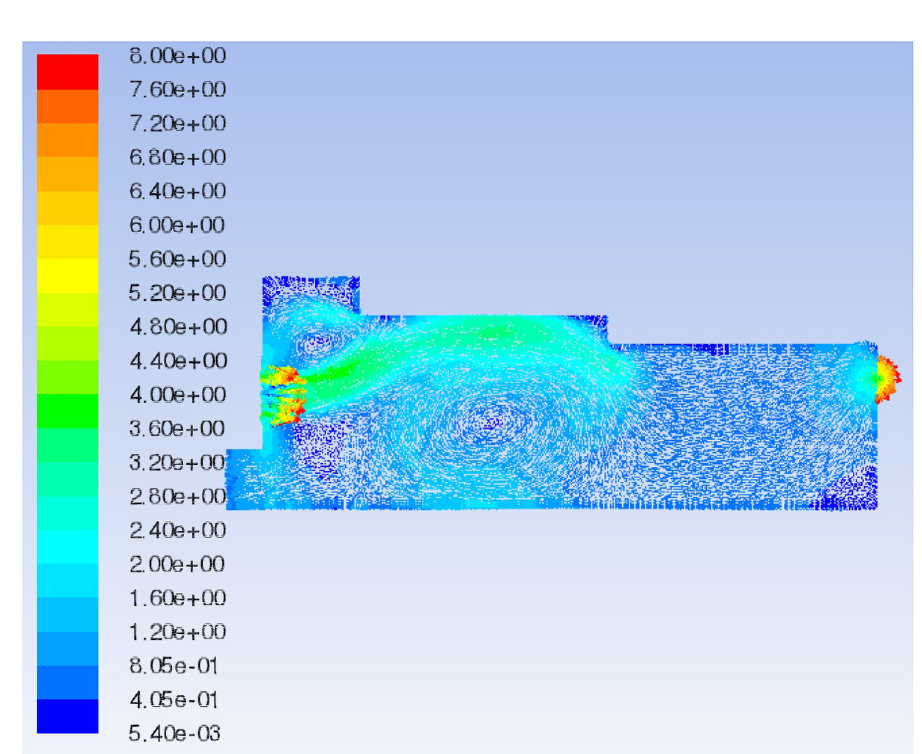
Fig 8. Flow field velocity vector of the original model.